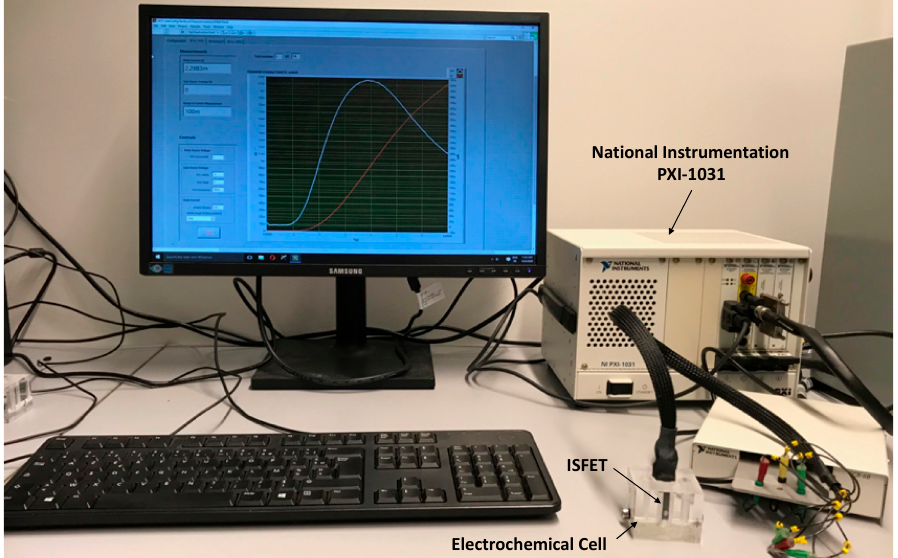
Figure 2. Measurement setup for testing ISFETs exposed to pH solution.